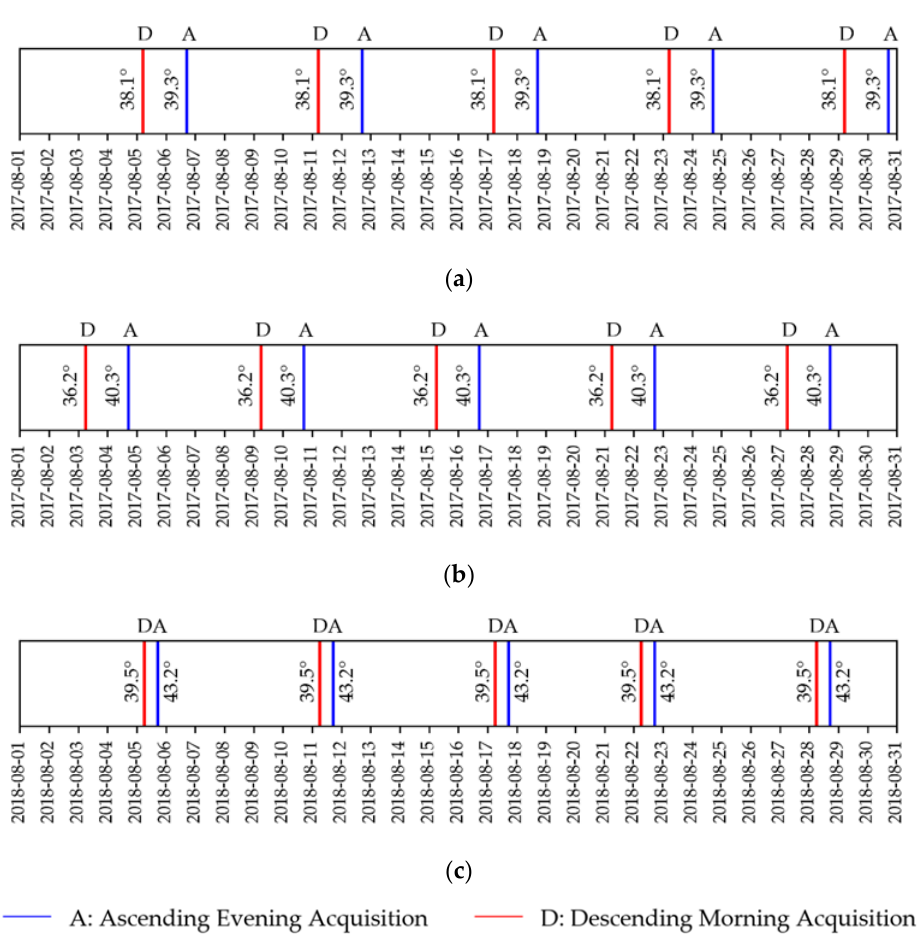
Figure 2. Frequency of the Sentinel-1 images in ascending “A” (afternoon) and descending “D” (morning) modes for one month over ( a ) Montpellier, ( b ) Tarbes and ( c ) Catalonia. The number next to each line represents the incidence angle for each acquisition.